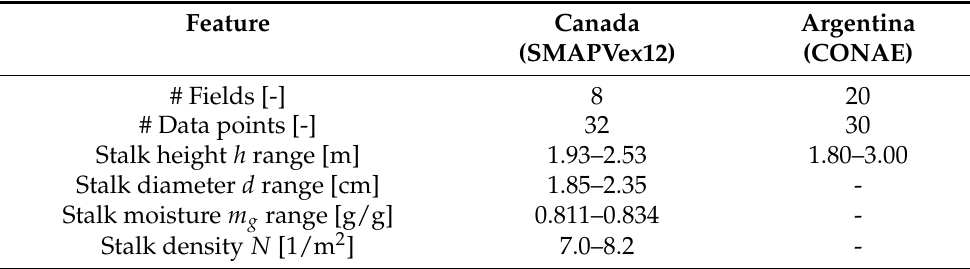
Table 1. Corn stalk features from the ground data collection for two field campaigns in Canada and